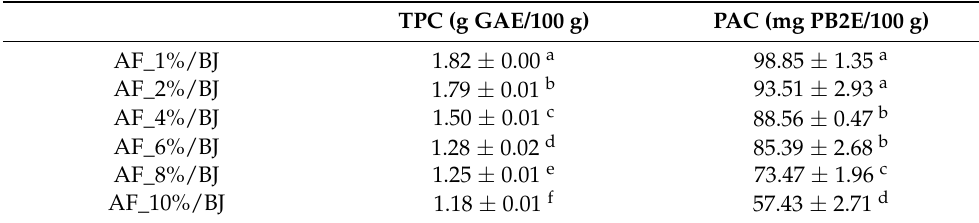
Table 1. Total polyphenols content (TPC) and total proanthocyanidins content (PAC) in apple fiber/blackberry juice